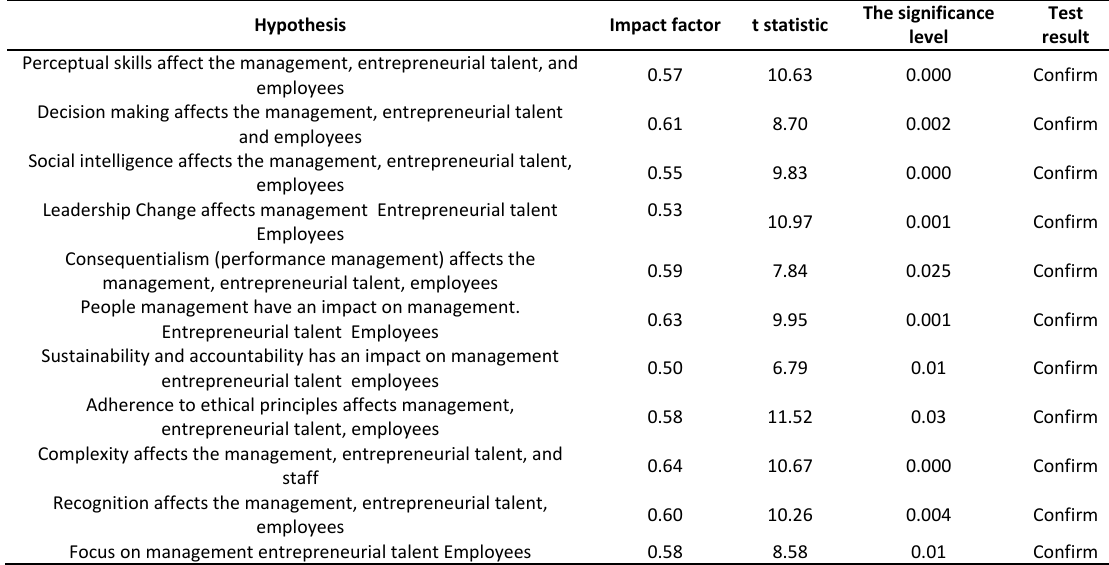
Table 7: Examination of route analysis to test the hypotheses